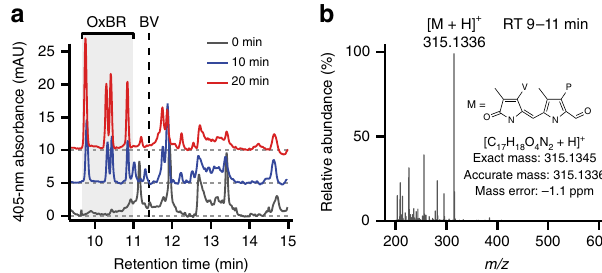
Fig. 3 Separation and mass spectrometry analysis of the major photo- oxidation products. a UV/vis chromatograms, at 405 nm, of photo- oxidation products of BR (OxBR) extracted from photobleached holoUnaG. For guidance, each chromatogram was offset by 0, 5 and 10 for irradiation times of 0 (gray), 10 (blue) and 20 min (red), respectively. Vertical black dashed line marks the retention time for BV obtained from a control experiment (Supplementary Fig. 4b, c). b An averaged mass spectrum for the retention time (RT) 9 – 11 min region of the LC – HRMS analysis. The most abundant ion species at m/z 315.1336 could correspond to the protonated ion ([M + H] + ) of the possible oxidation product (M) inserted as an